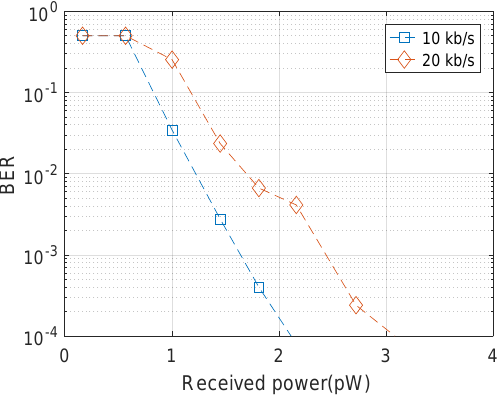
Figure 7. BER performance of the real-time communication link under simulated satellite